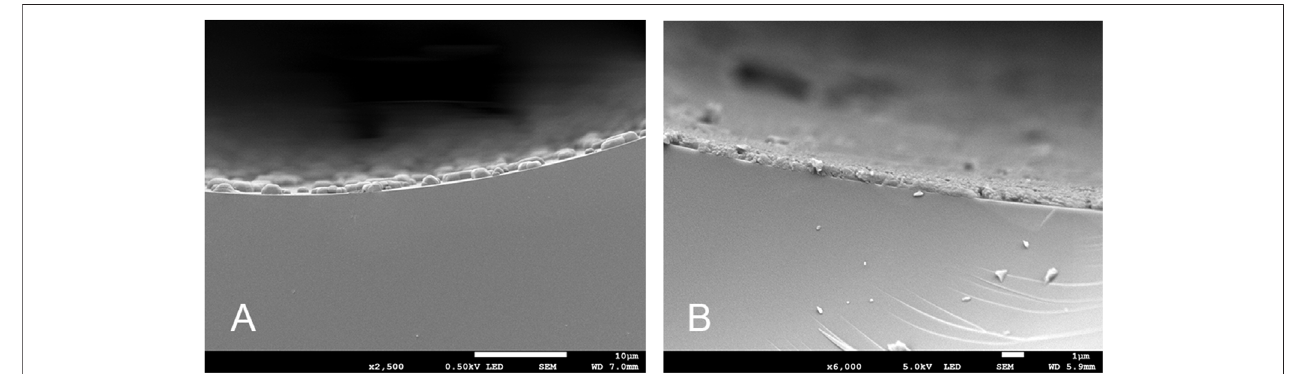
FIGURE 3 | SEM image of the inner wall of the capillary column (A) . NaCl particle coated; (B) . TPP coated).